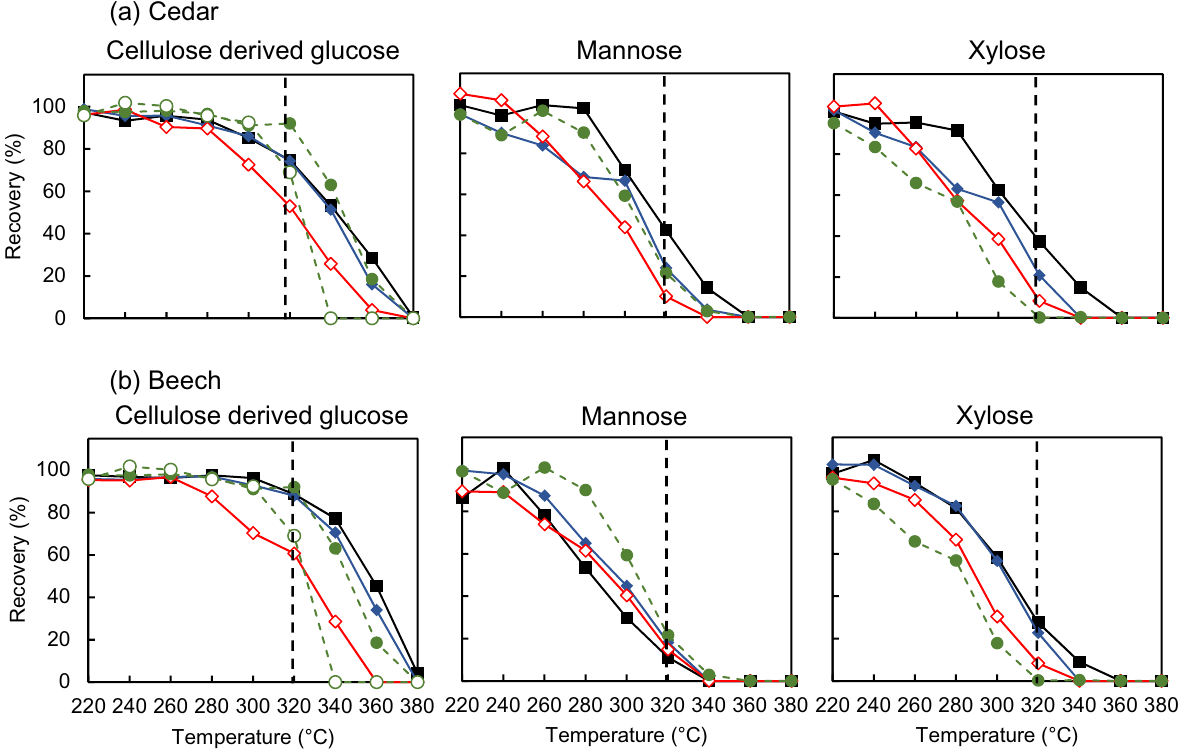
Fig. 8 Recovery rates of hydrolyzable sugars (cellulose-derived glucose, mannose and xylose) after pyrolysis of ball-milled a cedar and b beech wood for 10 min ( ) and 4 h ( ), compared with unmilled wood ( ), Whatman CF-11 cellulose ( : unmilled, : ball-milled (4 h) and isolated hemicellulose (